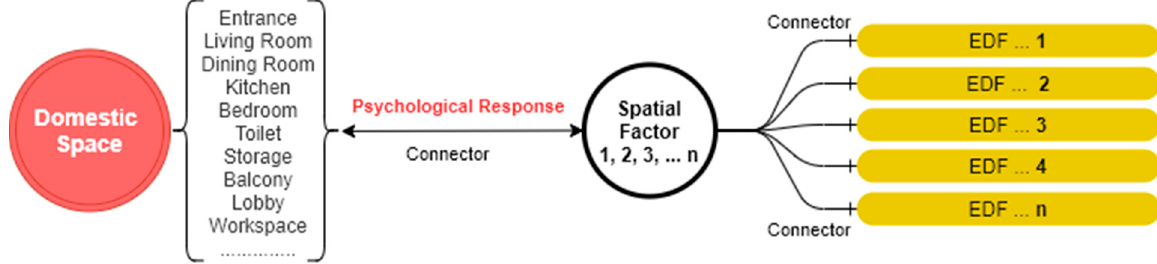
Figure 12. Conceptual parametric relationship of occupants' domestic experiences. Modified from Source: [4,43,64].